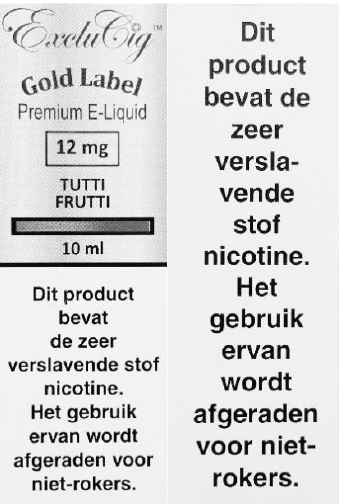
Figure 1. Example of the EU’s new text warning on an e-liquid packet (Left: the front of the e-liquid packet with the warning, “This product contains the highly addictive substance nicotine. Its use is discouraged for non-smokers”; right: the back of the packet with the same warning).